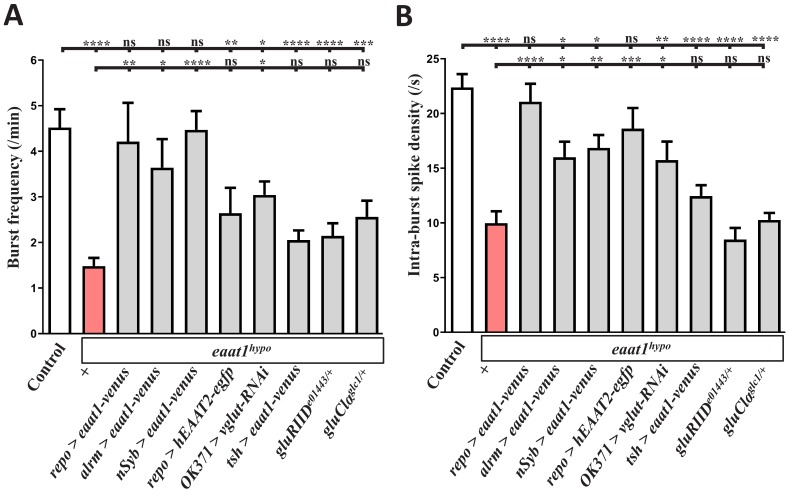
Analysis of the properties of the locomotor CPG output.Quantification data for (A) burst duration and (B) intra-burst spike density of the motor CPG output. Larval genotypes and controls (w1118) are indicated (n ≥ 7 animals for each genotype). P values: ns, no significance; *, p<0.05; **, p<0.01; ***, p<0.001; ****, p<0.0001. n: replicate number. Error bars indicate SEM. Statistics: one-way ANOVA with Tukey’s post hoc test.10.7554/eLife.47372.008Figure 1—figure supplement 3—source data 1.Source data for Figure 1—figure supplement 3.